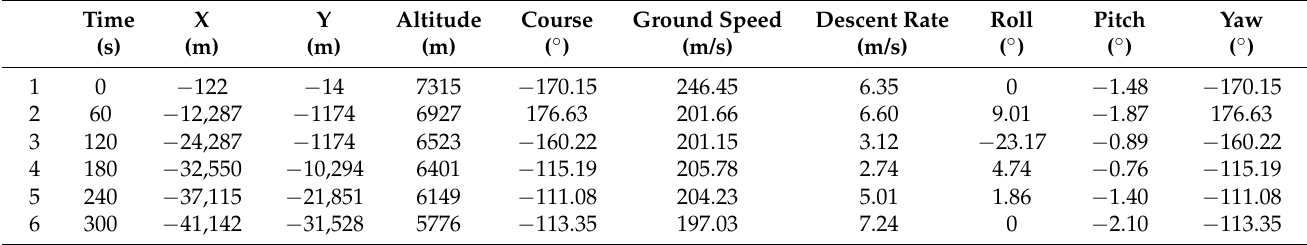
Table 1. Trajectory data for the real legit aircraft.